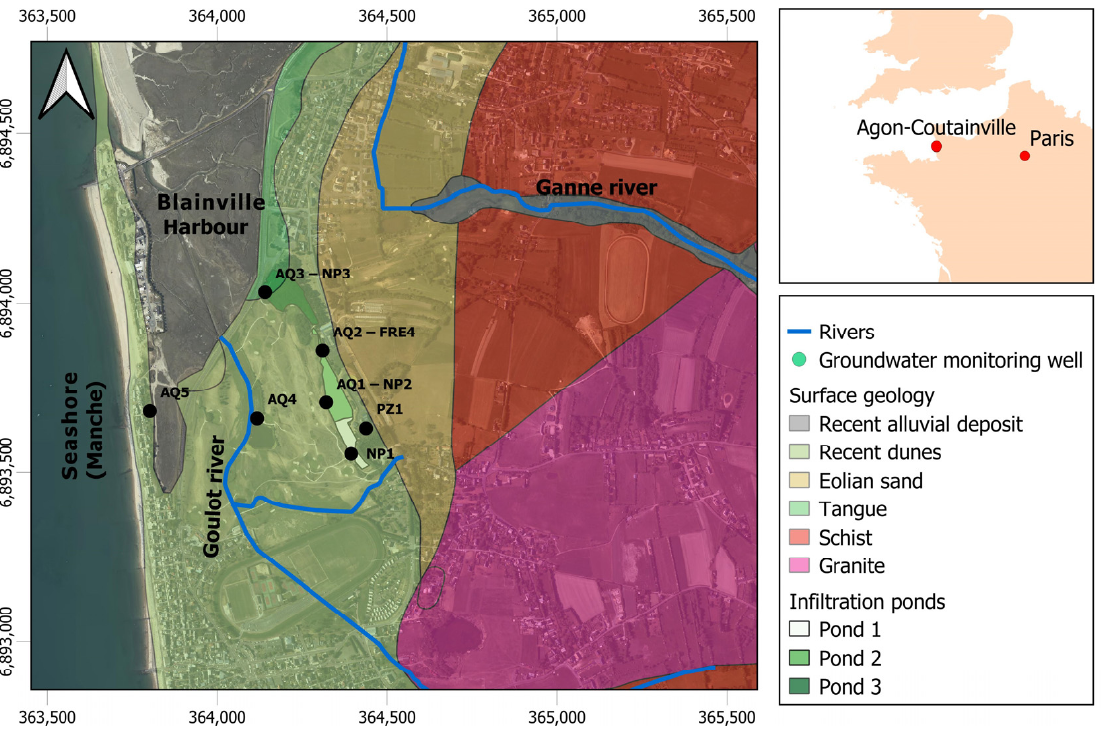
Figure 1. Location map of the SAT site at Agon-Coutainville (three infiltration ponds), observation wells (NP1, AQ1-NP2, AQ3-NP3, AQ2-FRE4, AQ4, AQ5, and Pz1), drainage network (blue lines), coastline and harbour, and surface geological formations.